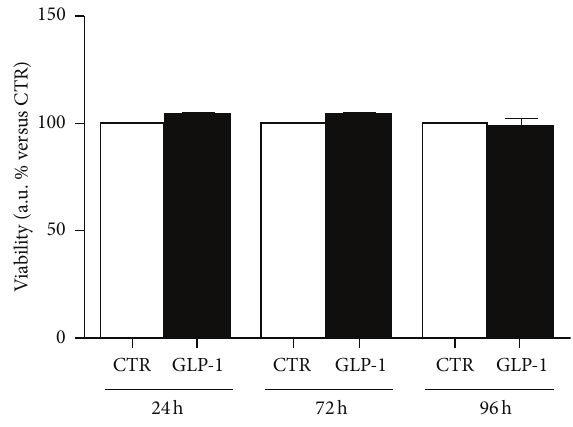
Figure 2: GLP-1 does not affect ARPE-19 cell viability. Cells were cultured for 24, 72, or 96 hours in the absence (CTR, white bars) or presence of 10 nmol/L GLP-1 (GPL-1, black bars). Cell proliferation rate was determined by a colorimetric method based on the formazan product of the tetrazolium compound MTS. Results showed the percentage of absorbance compared to CTR. Data were expressed as the mean ± SE of 3 independent